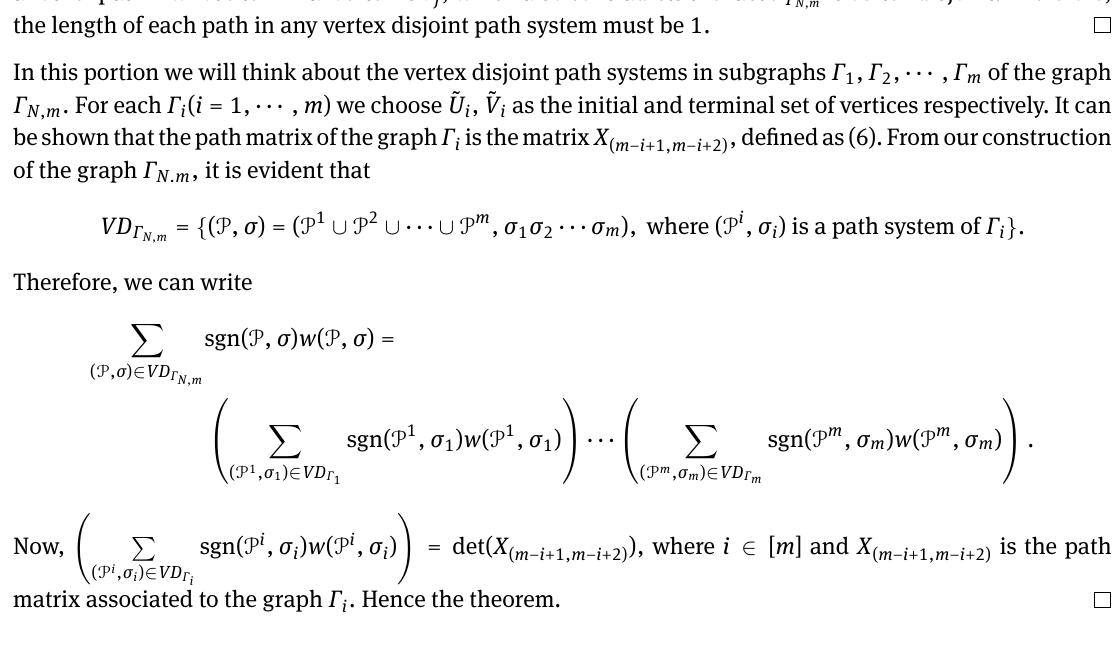
i.e, the second vertex of P (a vertex next to the initial vertex in P ) is either u i or v j . Suppose P is u (cid:96) u i · · · v k